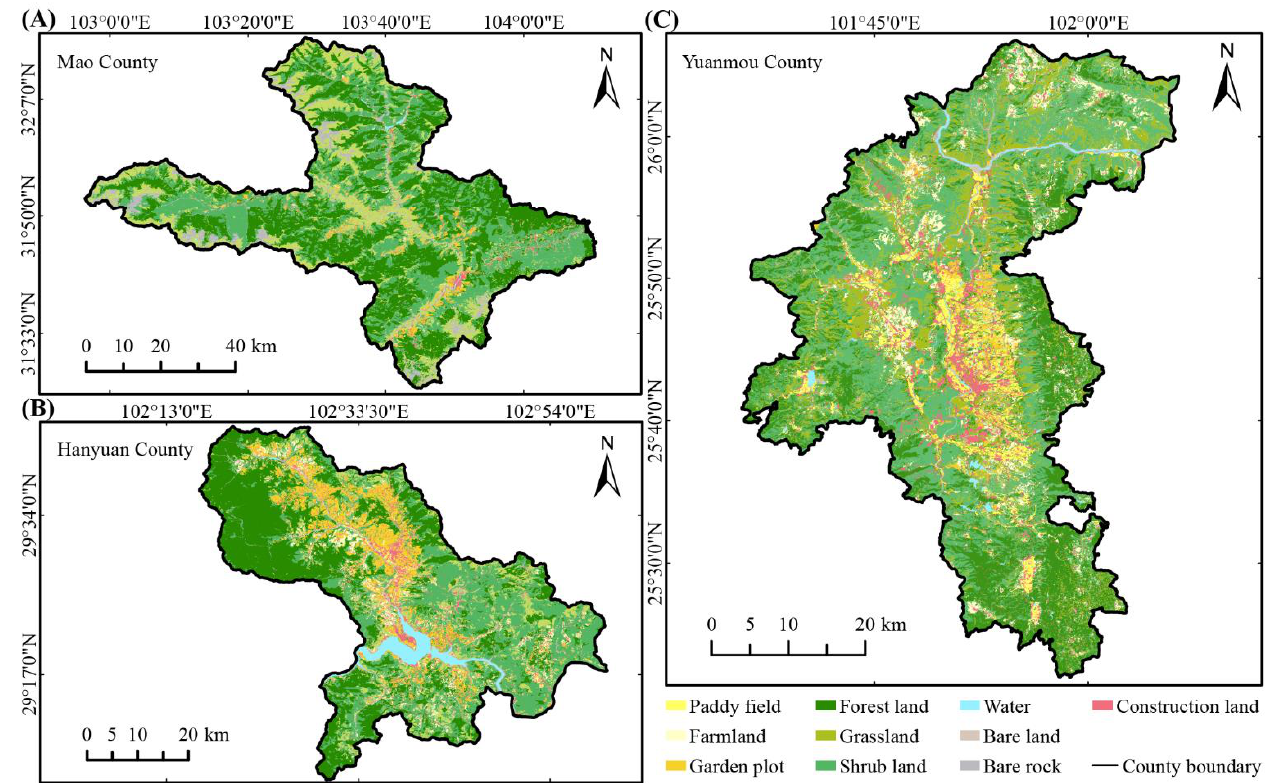
Figure 3. Spatial distribution of land use types in ( A ) Mao County, ( B ) Hanyuan County, and ( C ) Yuanmou County.